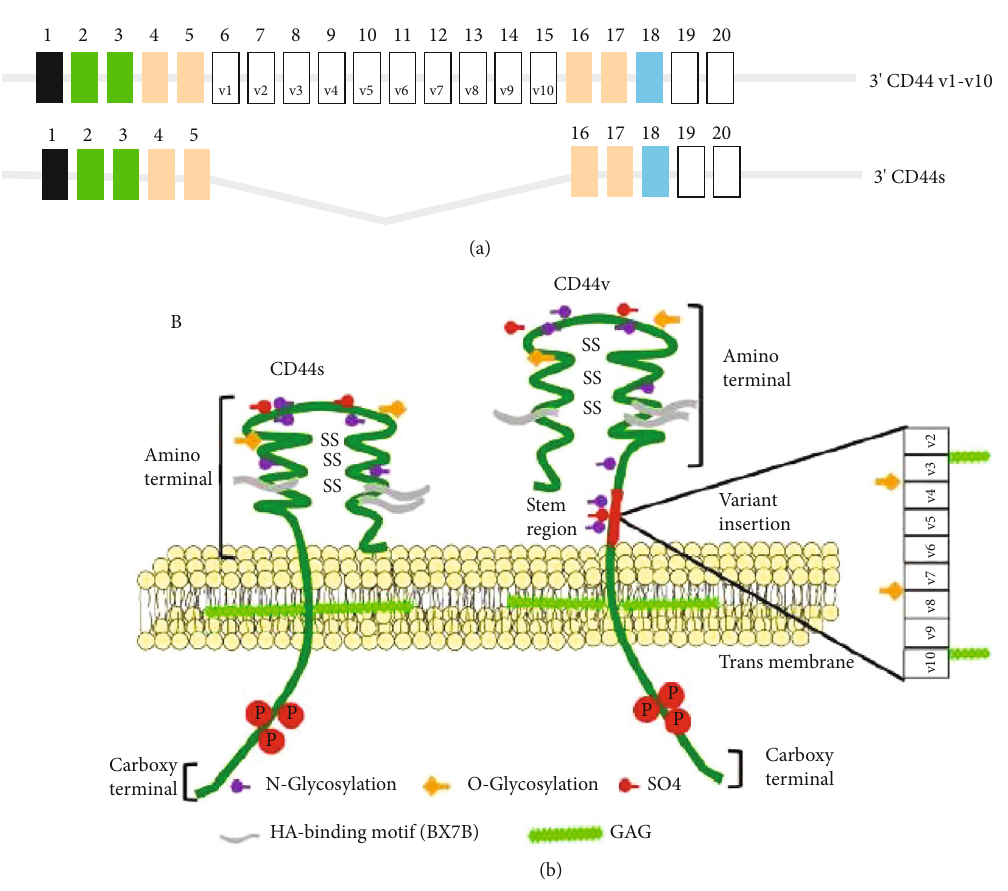
Figure 1: Structure of CD44. (a) The CD44 gene encodes 20 exons, of which exons 6 to 15 correspond to variable exons (v1-v10). The standard isoform only contains the constant exons. (b) CD44 is composed of an extracellular domain, a stem region, a transmembrane domain, and a cytoplasmic domain. CD44 is subject to posttranslational modi fi cations like N- or O-glycosylation and sulfation. The extracellular domain contains conserved disul fi de bridges and two BX7B domains, which are essential for hyaluronic acid (HA) binding. The cytoplasmic domain contains phosphorylation sites that regulate the interaction between CD44 and the cytoskeleton through linker proteins (modi fi ed from Misra, S. et al. Frontiers in Immunology 6:201, 2015)